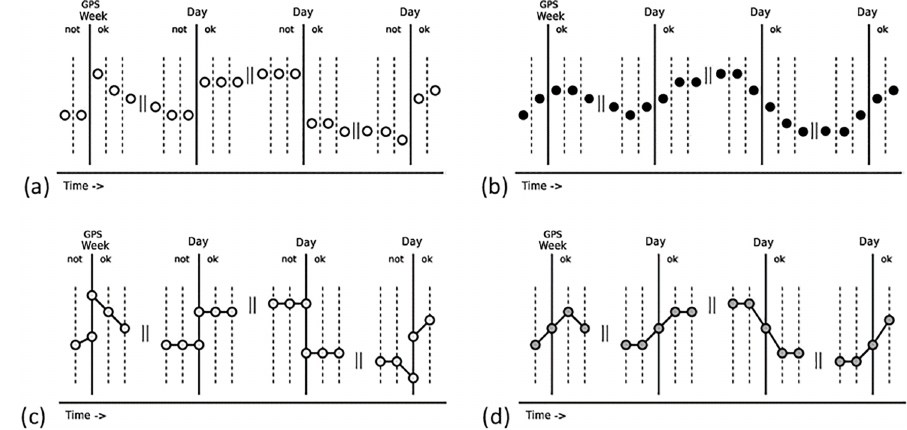
Figure 2. Charts of four variants of representation of tropospheric parameters in time ( x axis, with no specific dates). Right (b, d) and left (a, c) panels display estimates made with and without midnight combinations, respectively. Top (a, b) and bottom (c, d) panels display the piecewise constant and the linear model, respectively. Ok vs. not ok indicates a consistency vs. inconsistency, respectively, at daily or GPS week boundaries, the latter representing a specific case of the